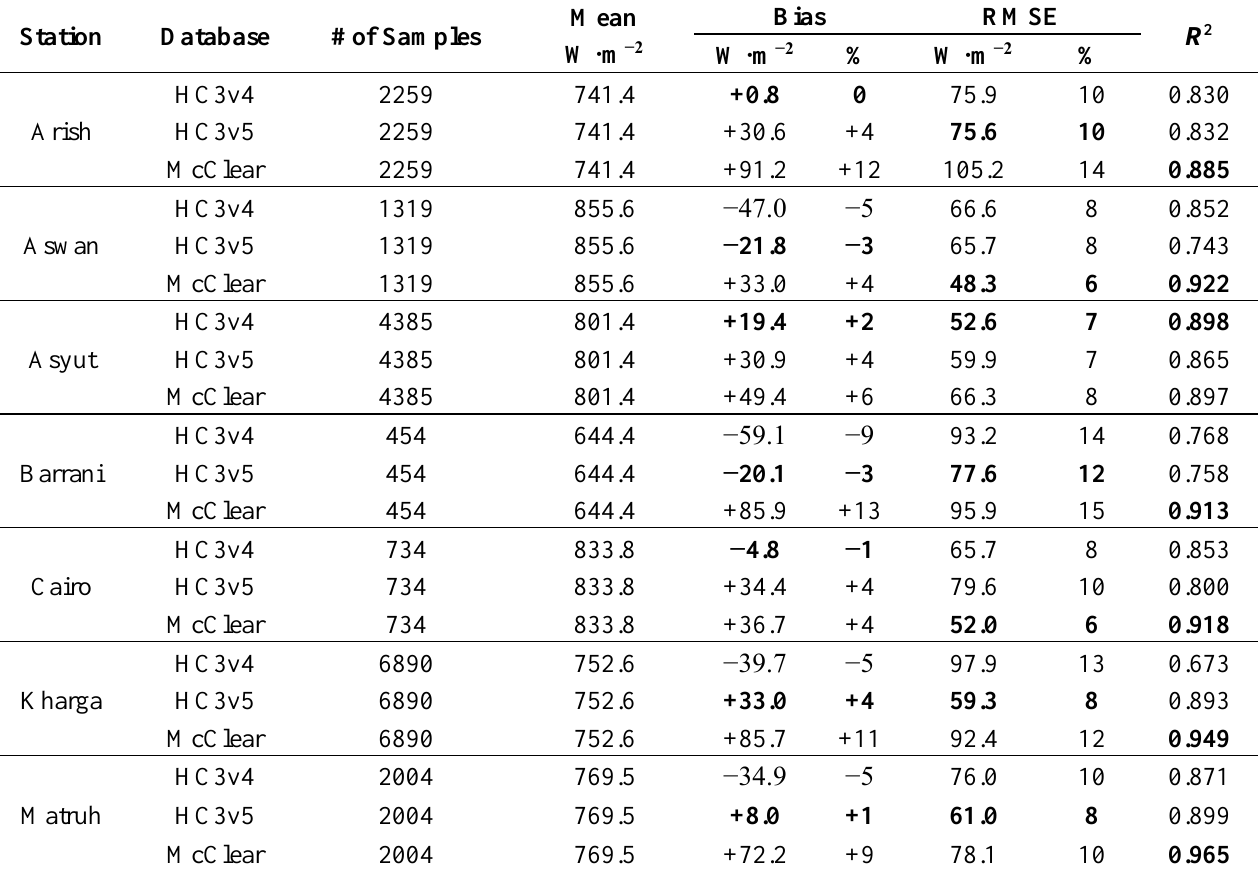
Table 2. Validation of the global horizontal irradiance (GHI) under cloud-free conditions, the best values for each station are in